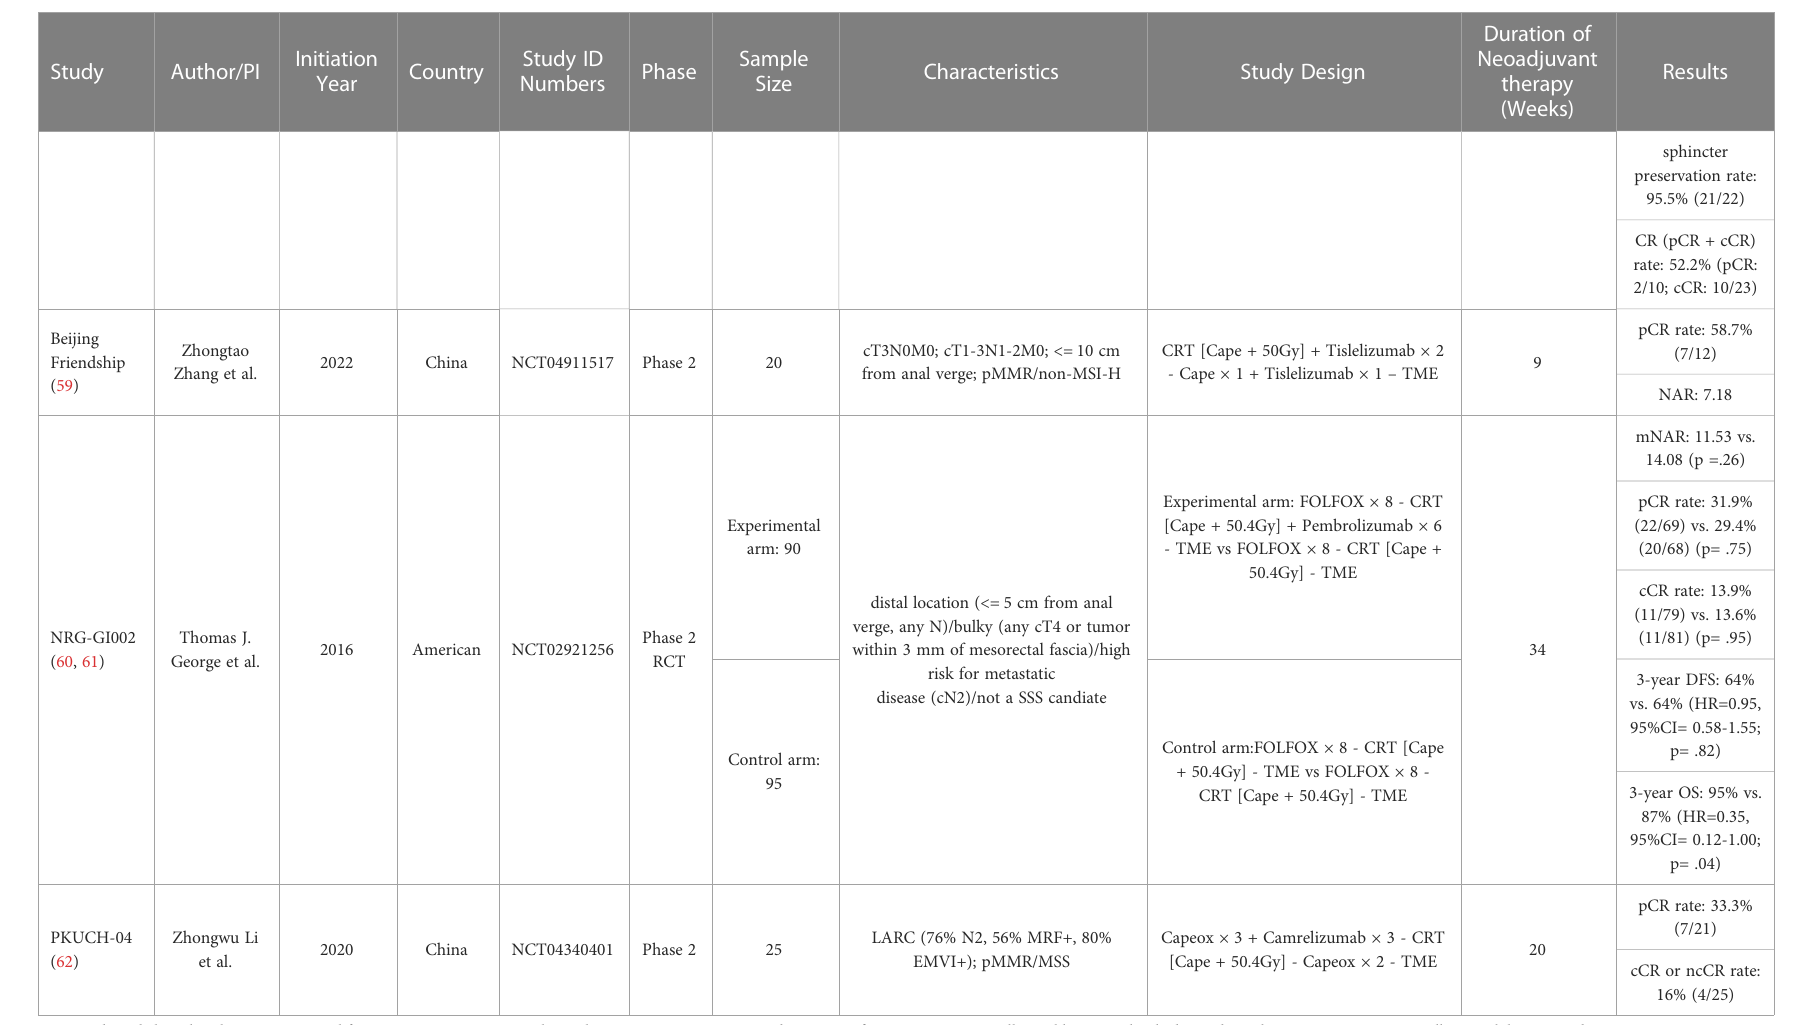
distal location (<=5 cm from anal verge, any N)/bulky (any cT4 or tumor within 3 mm of mesorectal fascia)/high risk for metastatic disease (cN2)/not a SSS candiate Control arm:FOLFOX × 8 - CRT [Cape + 50.4Gy] - TME vs FOLFOX × 8